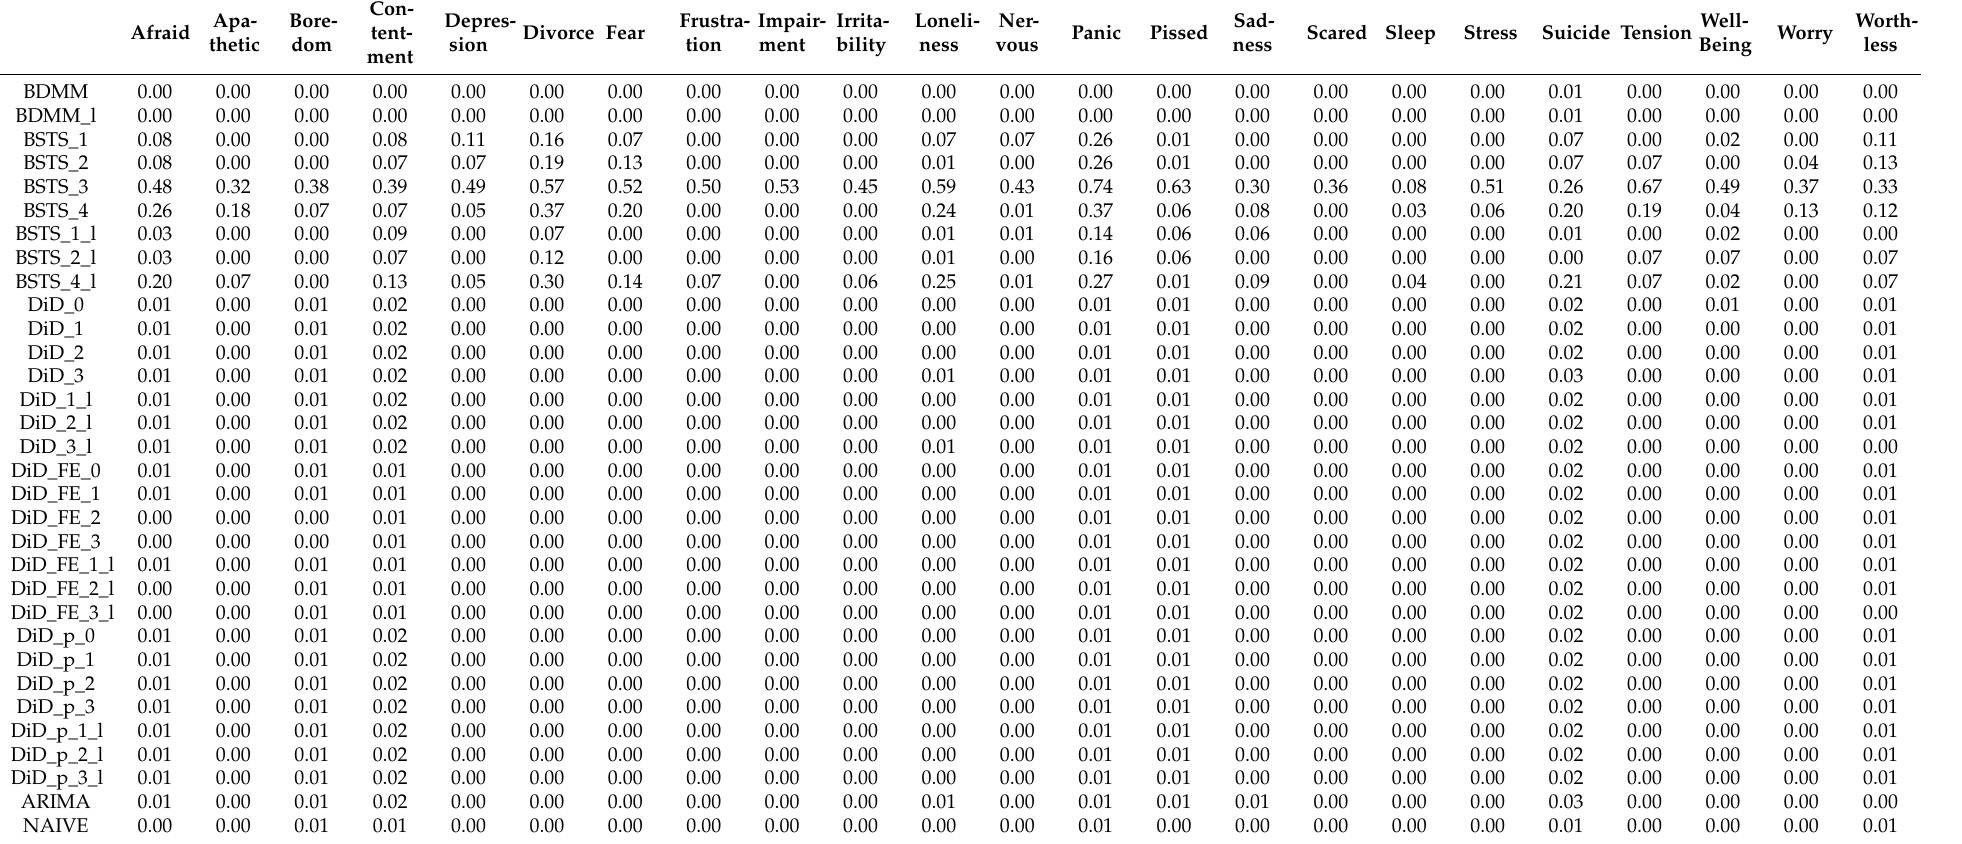
Table 6. Average p -values of the DM test over the